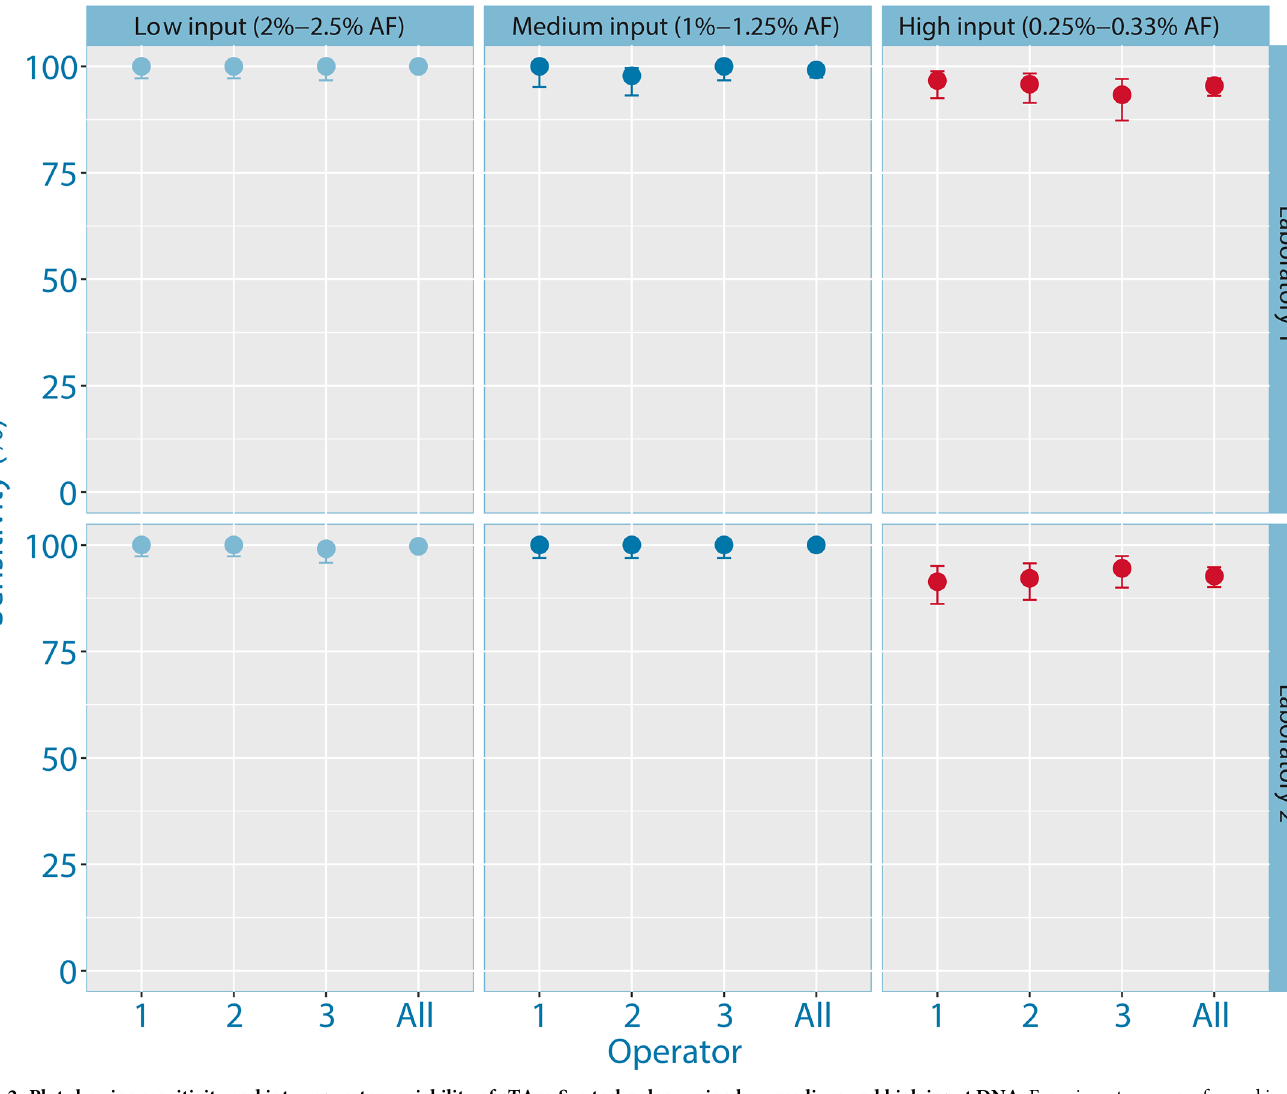
Table 2. Sensitivity of the eTAm-Seq technology with 8000 amplifiable copies of DNA input per sample. Laboratory 1 Laboratory 2